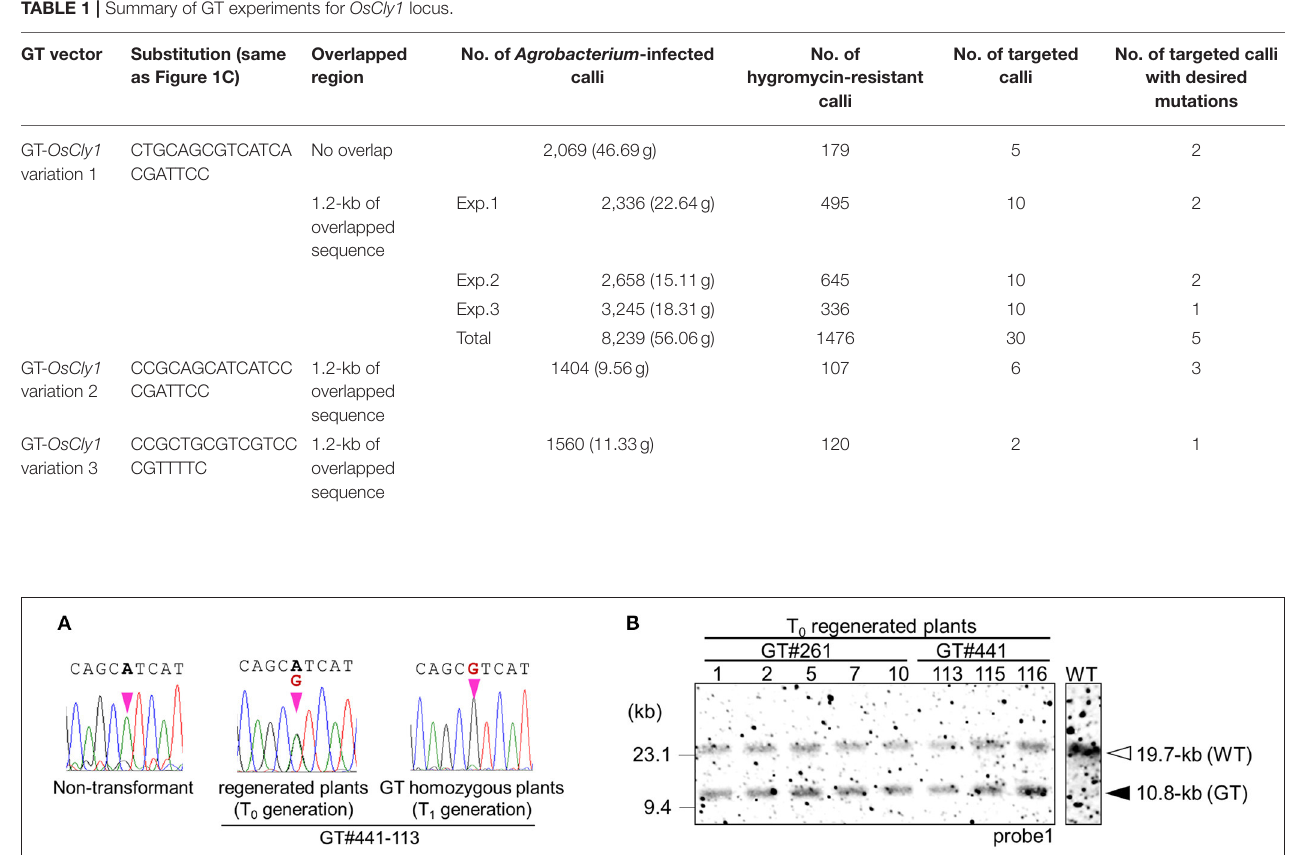
FIGURE 2 | Molecular analyses confirming GT events in GT#261 and GT#441. (A) Sequencing chromatograms at the mutation site on the OsCly1 gene in a non-transformed plant, and in GT plants from the T 0 and T 1 generations. (B) Southern blot analyses with probe1 ( Figure 1 ) using Eco RV-digested genomic DNA of regenerated plants from GT calli of GT#261 and GT#441. White and black triangles indicated bands derived from WT and GT allele,